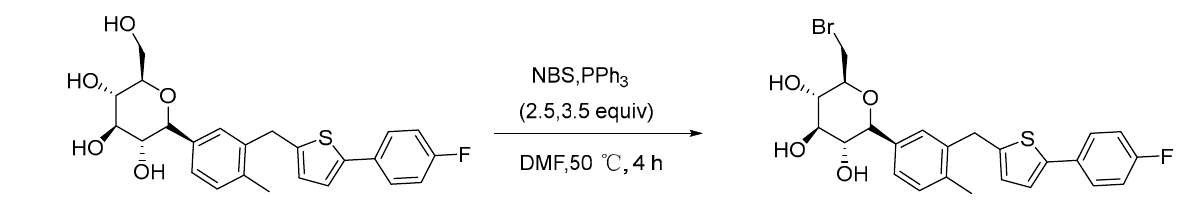
Figure 3. Modification of CAN. Bromination products of hydroxysilyl ether of CAN.